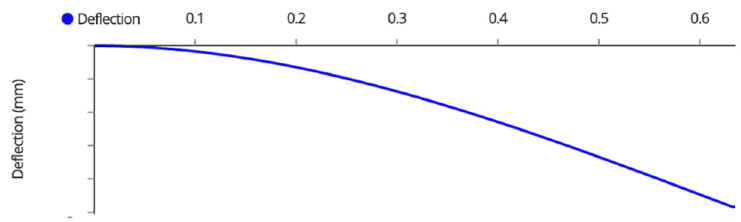
The deflection diagram is shown in Figure A20.